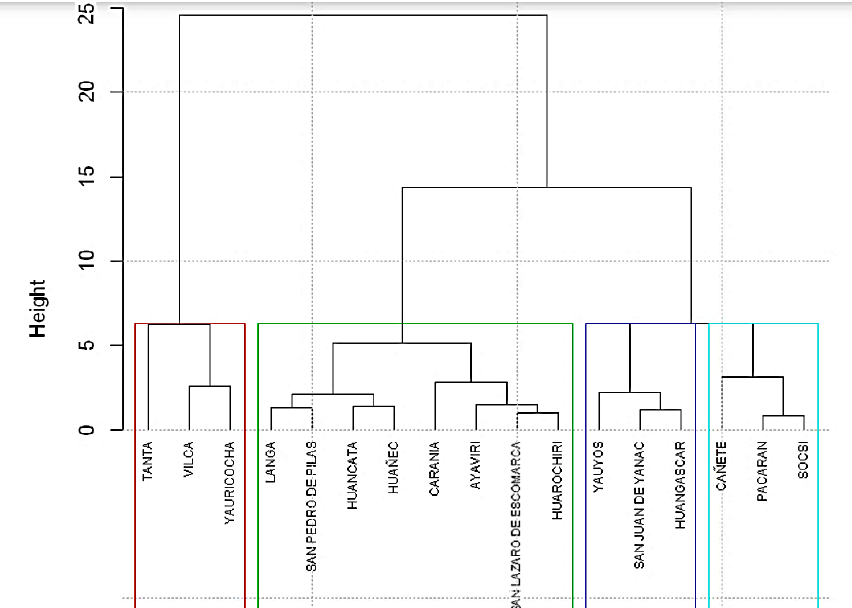
Figure 7. Ward method clustering: Dendrogram (2001–2019 period).